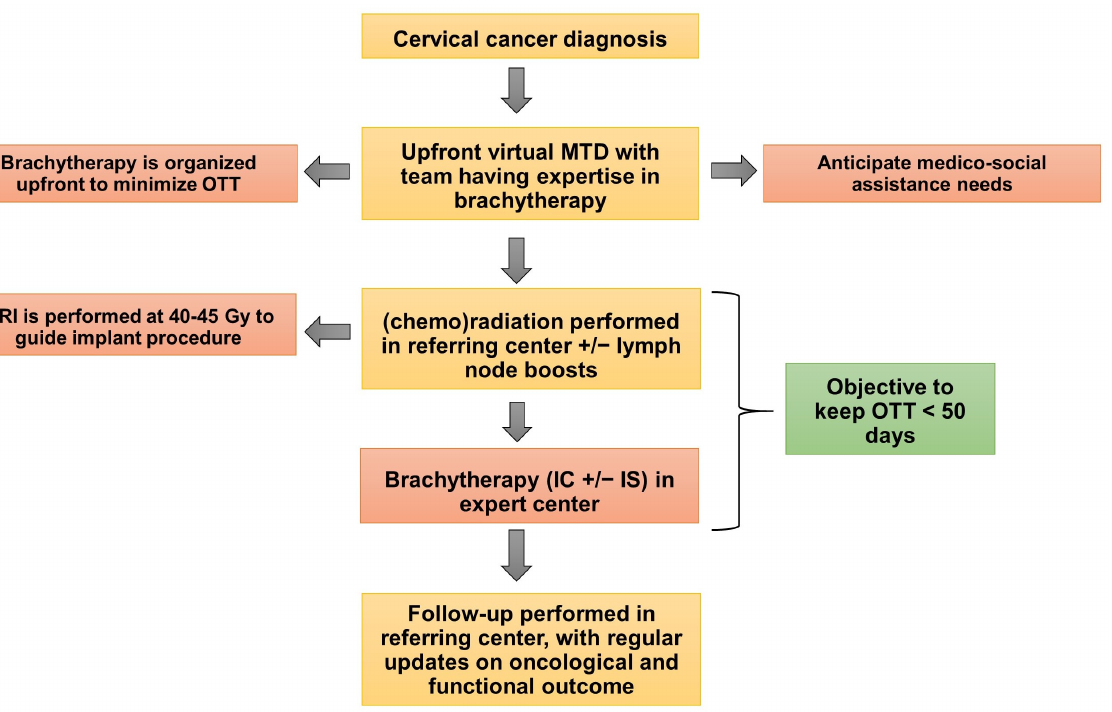
Figure 2. Example of a process of patient navigation for brachytherapy. Abbreviations: MRI: magnetic resonance imaging, IC: intracavitary, IS: interstitial, MTD: